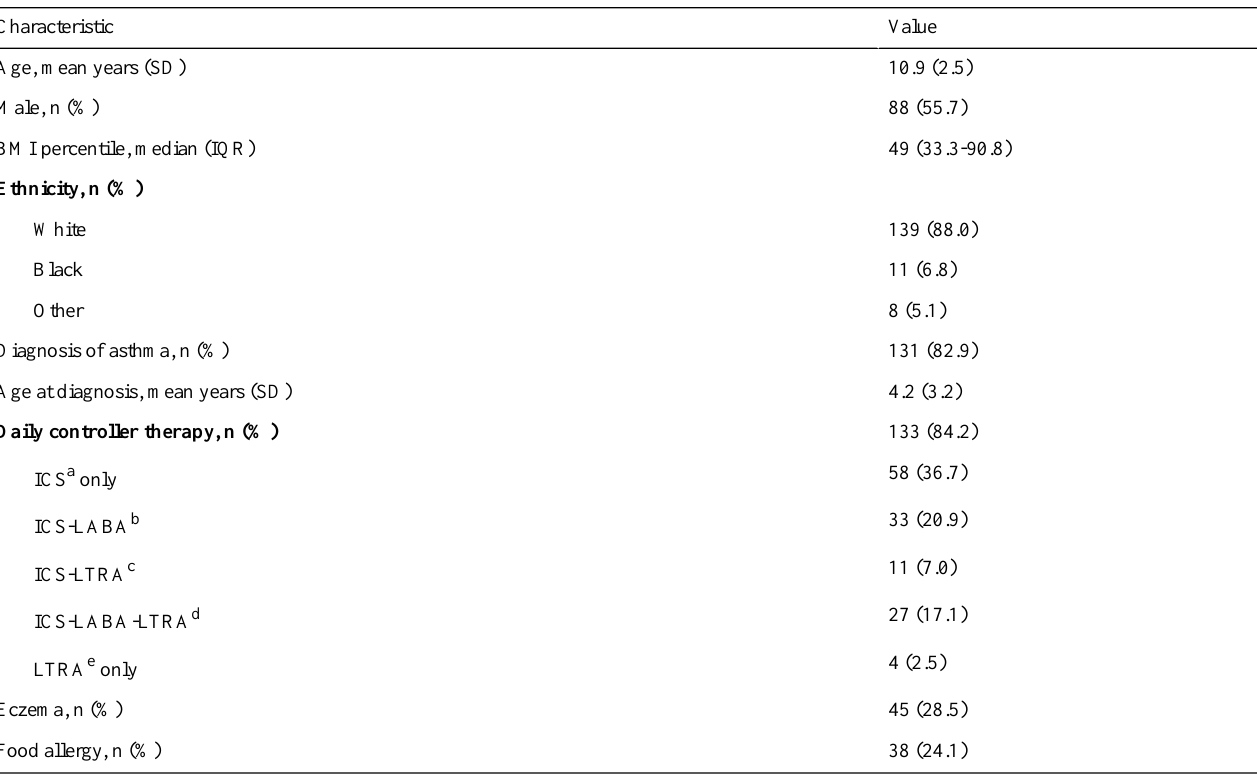
Table 1. Selected baseline characteristics of participants